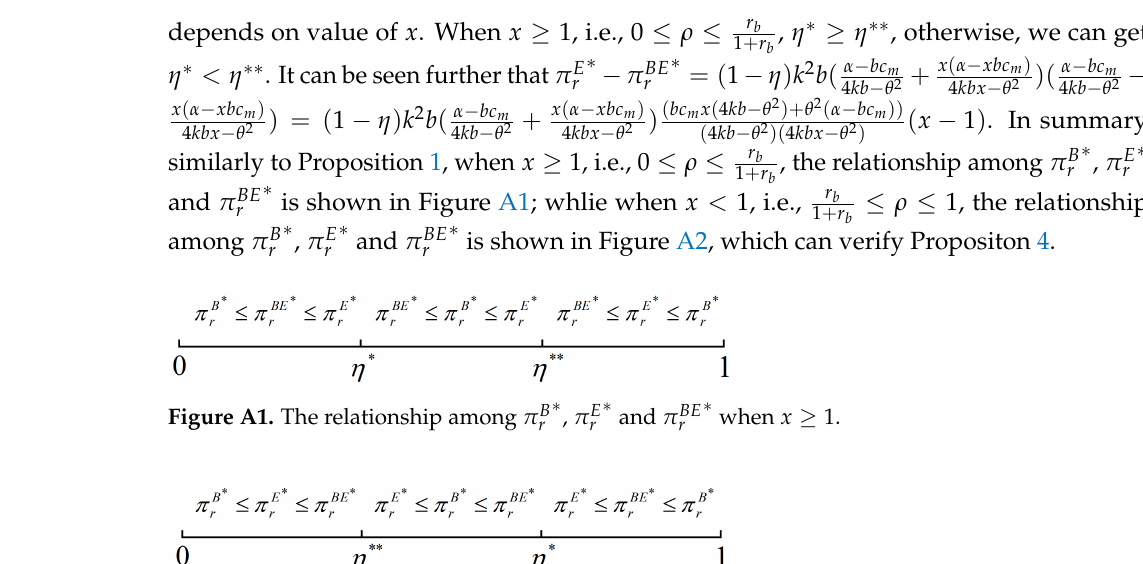
∗ ∗ ∗ , π E r and π BE r when x <